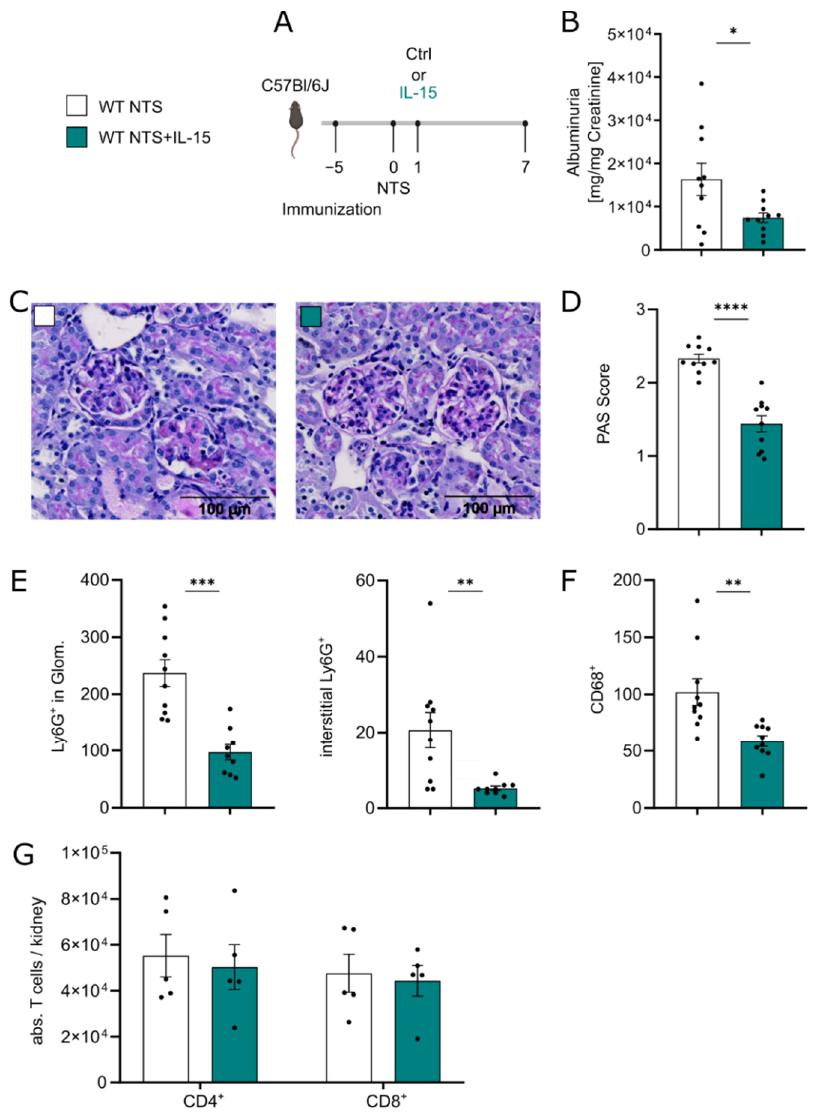
Figure 1. Administration of low-dose rIL-15 is protective in NTS. ( A ) Experimental timeline of 7 days NTS with single low-dose rIL-15 intervention. ( B ) Ratio of urinary albumin to creatinine. ( C ) Repre- sentative histological PAS staining ( × 40 magnification) and ( D ) scoring of PAS-positive material in murine kidney tissue. ( E ) Immunohistochemical quantification of glomerular and interstitial Ly6G + cells and ( F ) renal CD68 + in 6hpf. ( G ) Flow cytometry analysis of CD4 + and CD8 + T cells in kidney tissue. Data in B-F represent two independent experiments. Black dots represent individual values of respective mice. * p ≤ 0.05, ** p ≤ 0.01, *** p ≤ 0.001, **** p ≤ 0.0001. Statistical analysis used